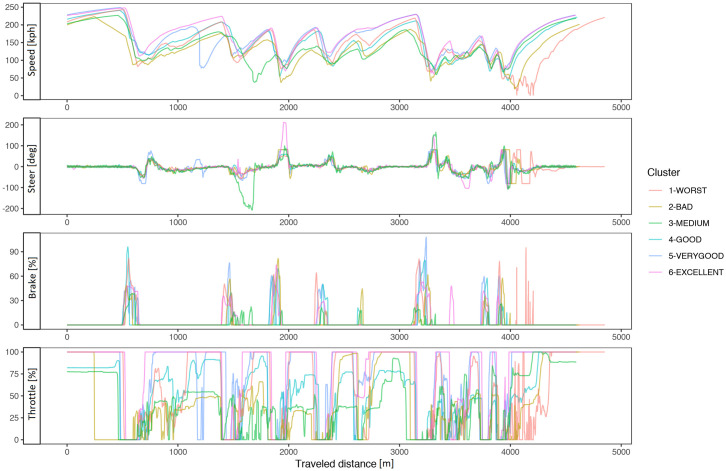
Best lap times.Best lap times by performance level.